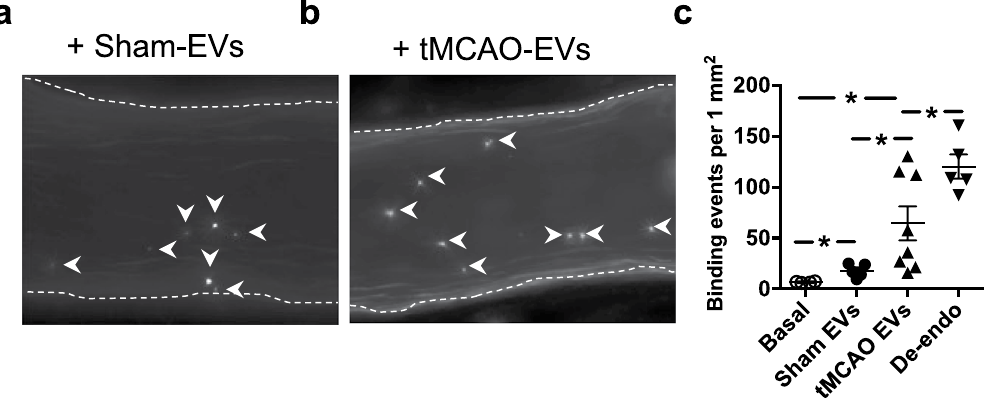
Figure 5. RGD protein bearing extracellular vesicles (EVs) promote platelet adhesion under flow . ( a,b ) Fluorescence images of representative time-lapse recording demonstrate firm binding of CFSE-labelled platelets on the luminal surface of the isolated mouse MCA pre-treated with EVs isolated from sham and tMCAO animals, and in the presence of physiological pressure and flow (white arrowheads show stationary platelets). ( c ) Summary data show adhered platelets (white arrow heads) under basal condition, and after the endothelium was removed with air (De-endo), or when sham EVs or EVs from tMCAO were delivered prior to platelets. Data are mean ± SEM, * p <